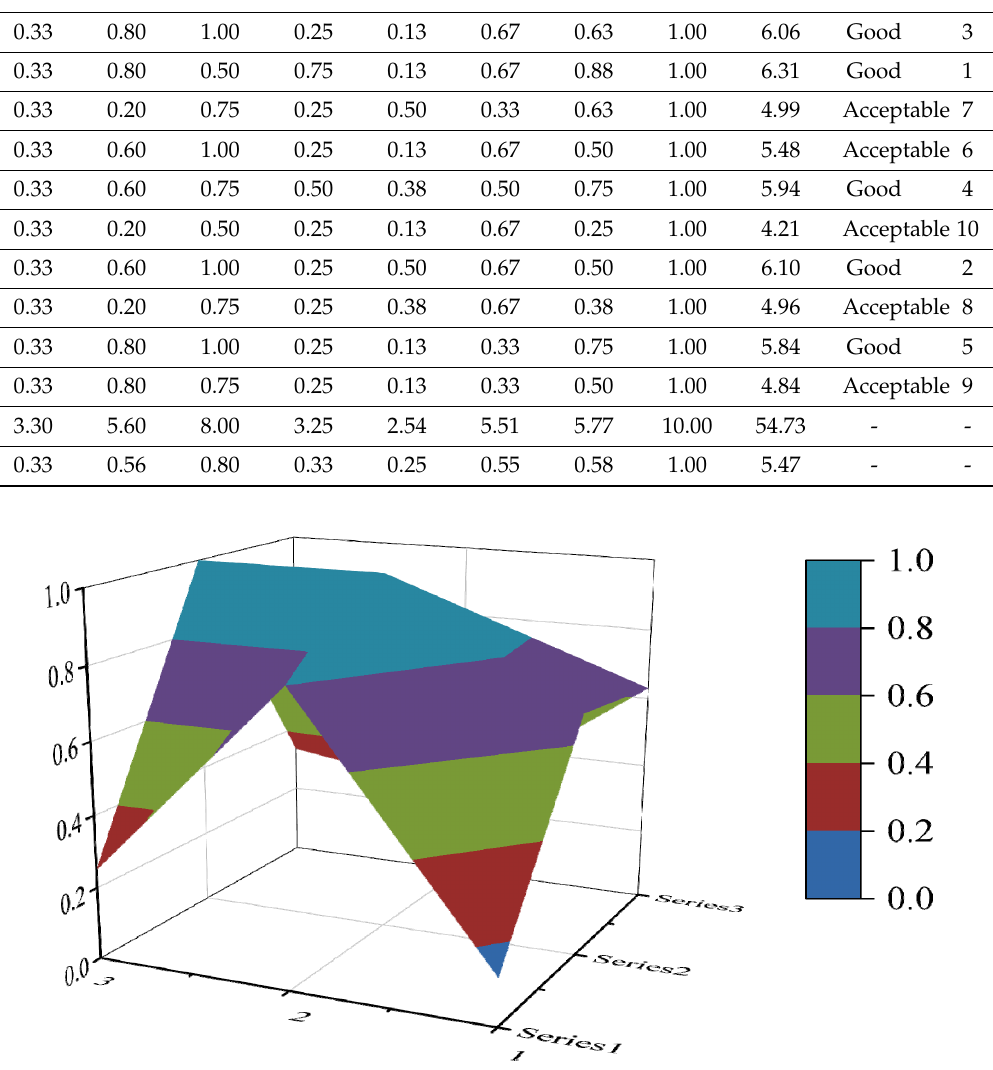
Figure 3. The PMC surface of P2.